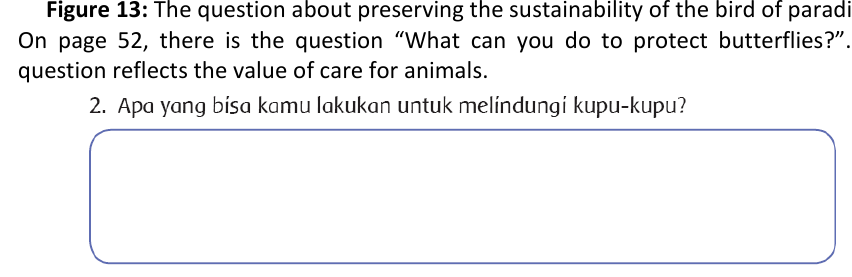
Figure 14: The question about protecting butterflies